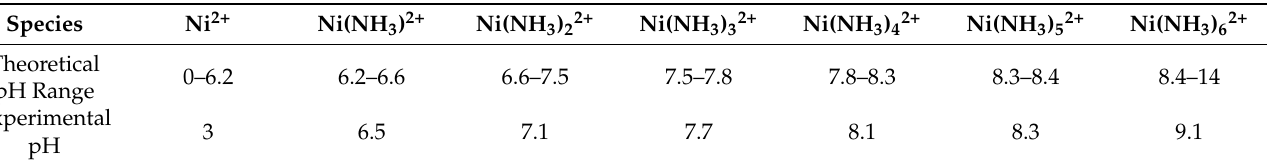
Table 1. The theoretical (based on the E -pH diagram in Figure 2 and experimental pH values of solution with 0.2 M NiCl 2 , 2 M NH 4 Cl, and 1 M NaCl for the formation of different Ni(NH 3 ) n 2+ complexes.